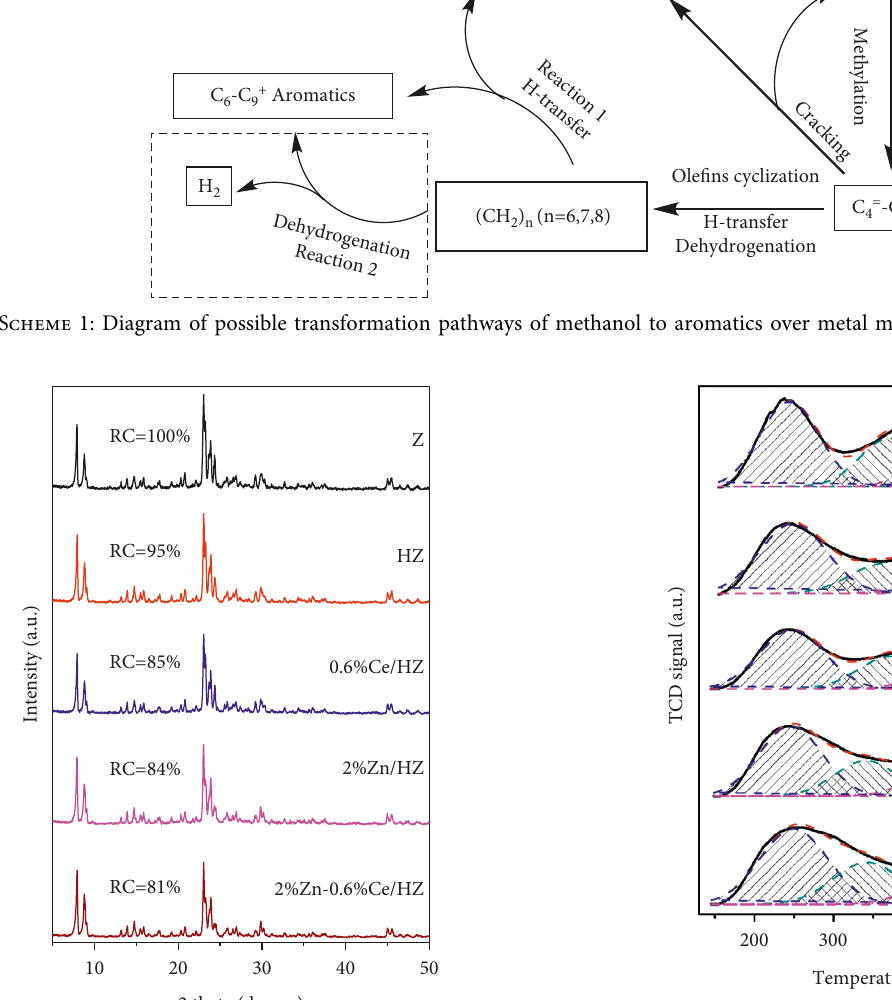
Figure 3: NH 3 -TPD profiles of different